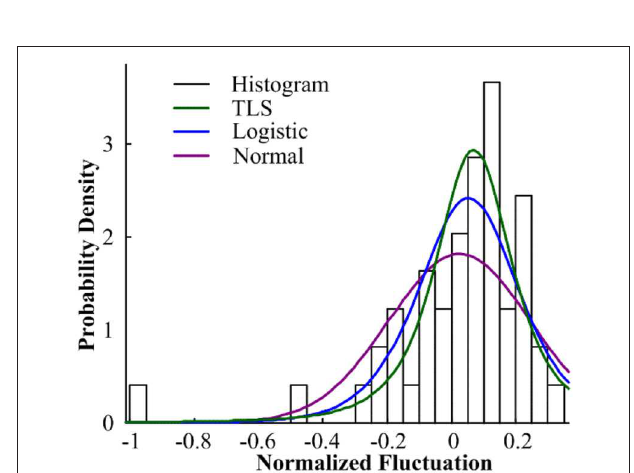
FIGURE 3 | Probability distribution fitting of random components of PV output in Xichang City on July 20, 2018.